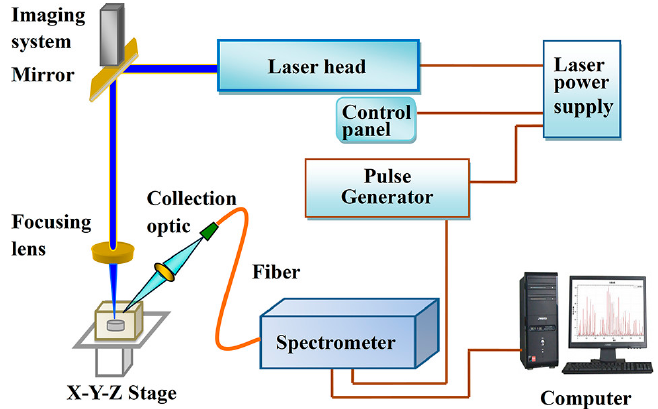
Figure 6. Schematic diagram of the LIBS experimental setup. Adapted from [97], with permission from © 2018 American Chemical Society.